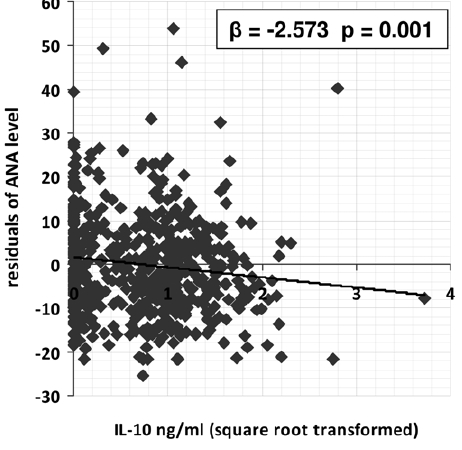
Figure 5. Effect of antihelminthic treatment on anti-nuclear antibody (ANA) levels. Increase in of ANA levels in school children from the high schistosome infection area, Magaya six months after anti- helminthic treatment with praziquantel.